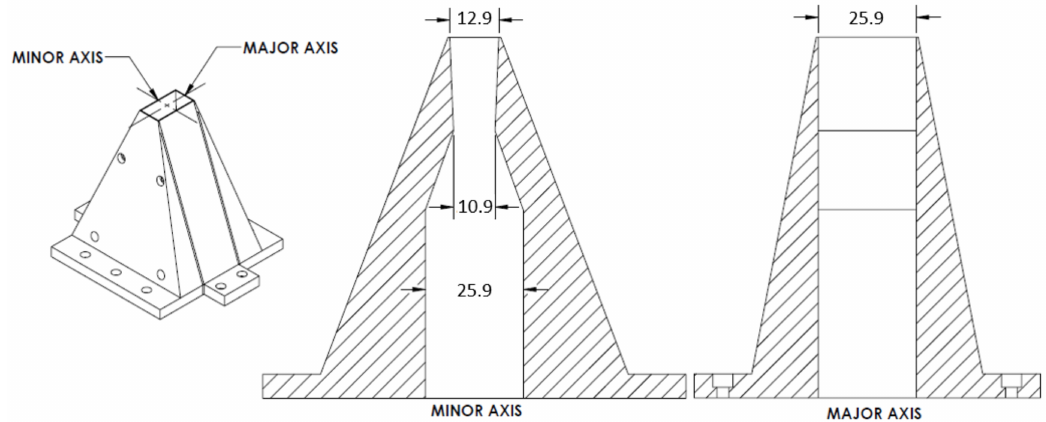
Figure 1. AR 2 rectangular nozzle geometry (all dimensions are in mm) taken from Viswanath et al.